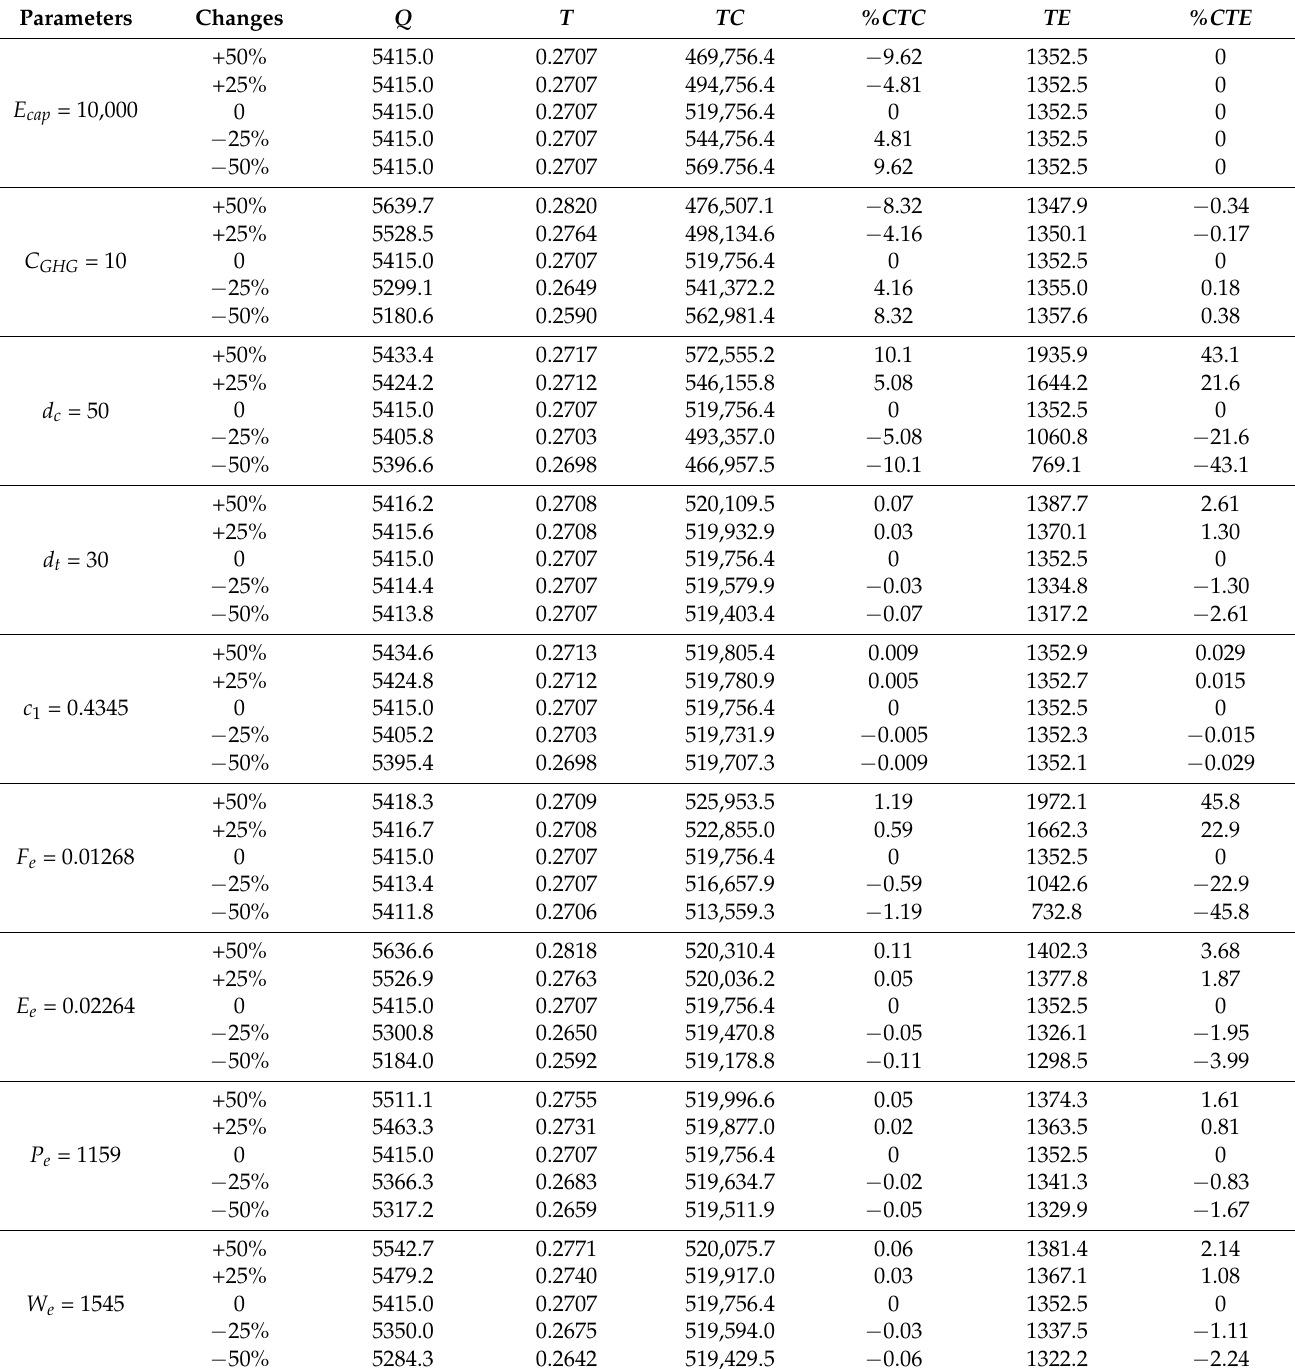
Table 3. Effects of changes in the cap-and-trade and environmental-related parameter